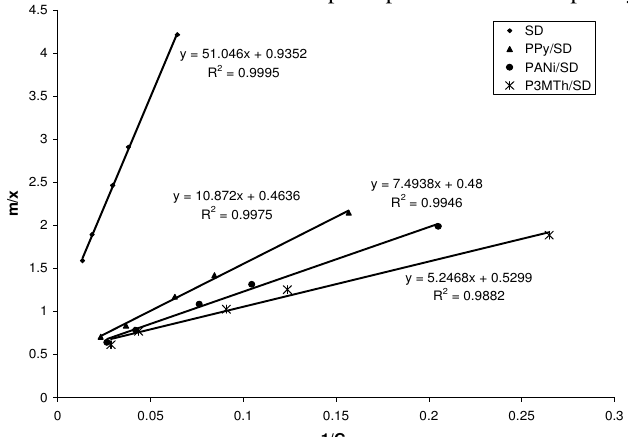
Figure 5 . Lungmuir isotherm SD, PPy/SD, PANi/SD and P3MTh/SD for sorption of